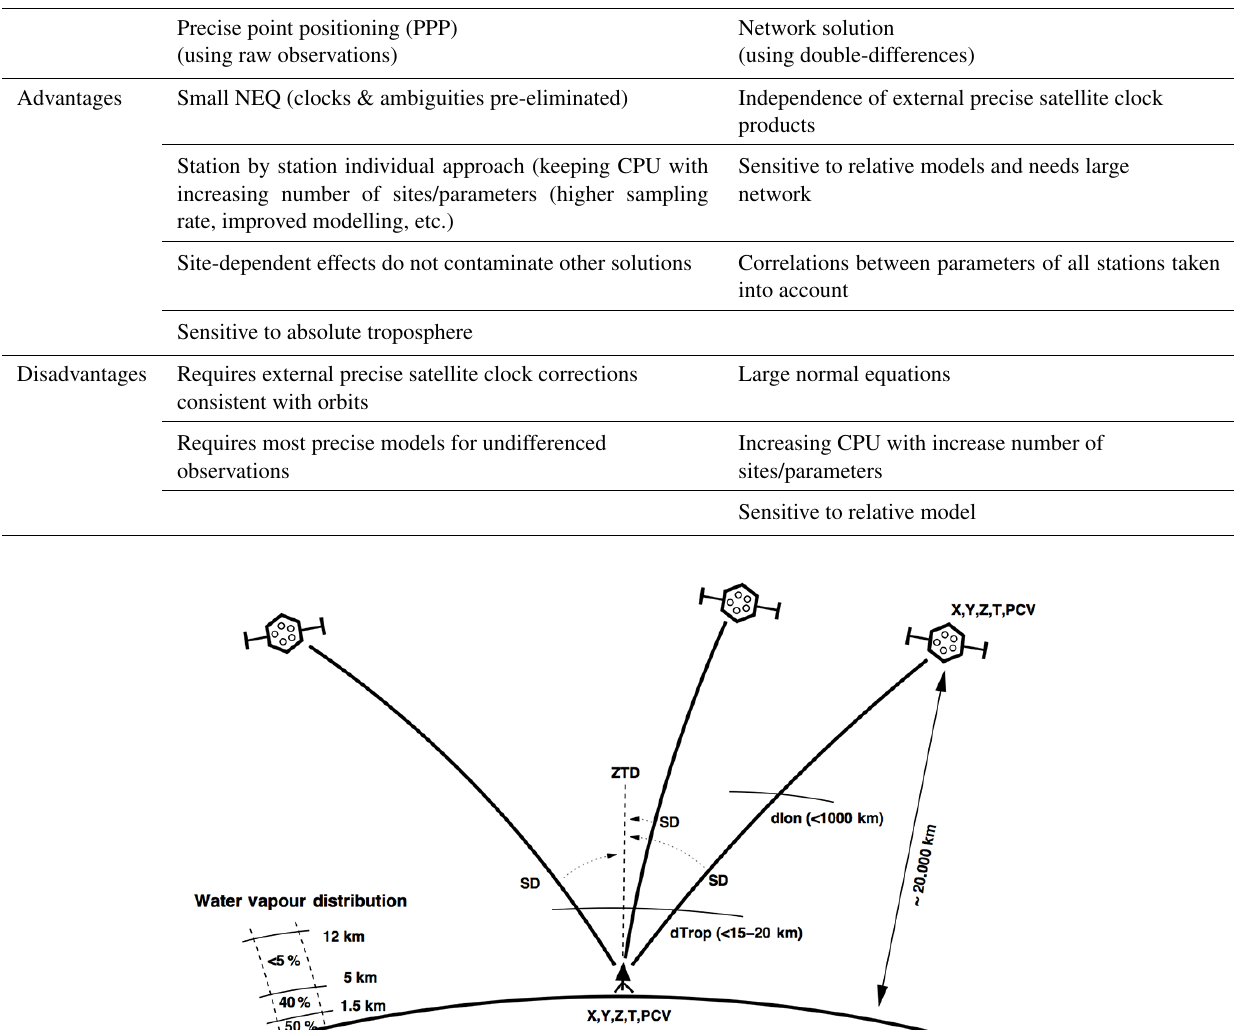
Table 2. PPP vs. network GNSS processing strategy.